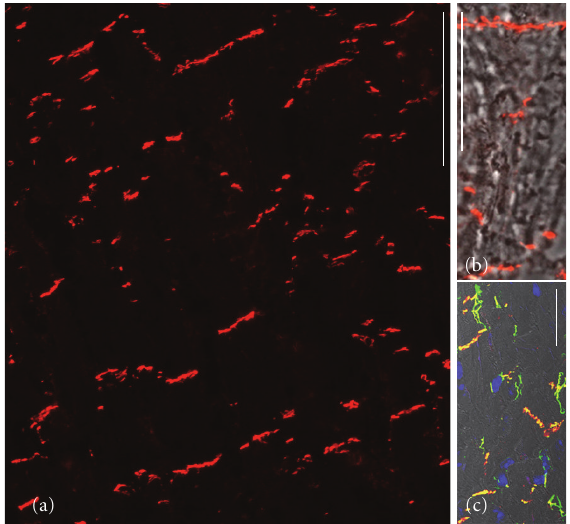
Figure 3: Micrographs showing the immunolocalization of the desmosomal plaque protein, desmoplakin, on cryostat sections through the murine myocardium. (a) Immunofluorescence micro- graph showing the localization of desmoplakin (red) in all composite junction structures of the intercalated disks (IDs). (b) Immunofluorescence micrograph showing desmoplakin (red) labeling of the composite junctions on the background of phase- contrast optics. (c) Merged image showing plakophilin-2 (red), β - catenin (green) and nuclear DAPI-staining (blue), on an interfer- ence contrast microscopy background. Composite junctions (CJs) are characterized by their yellow merge colour whereas the zonulae adhaerentes and other AJs of the capillary endothelial cell layers here show only β -catenin-positivity. Bar in (a): 100 μ m; bar in (b): 50 μ m; bar in (c): 25 μ m. Figure 4: Schematic comparison of the di